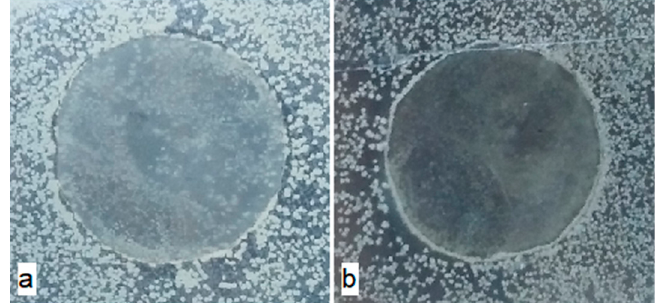
Figure 7. External appearance of polyethylene without birch bark extract ( a ) and polyethylene with 1.0% content of birch bark extract ( b ) and the use of ultrasonic treatment after the incubation under the influence of C. albicans for 24 h.